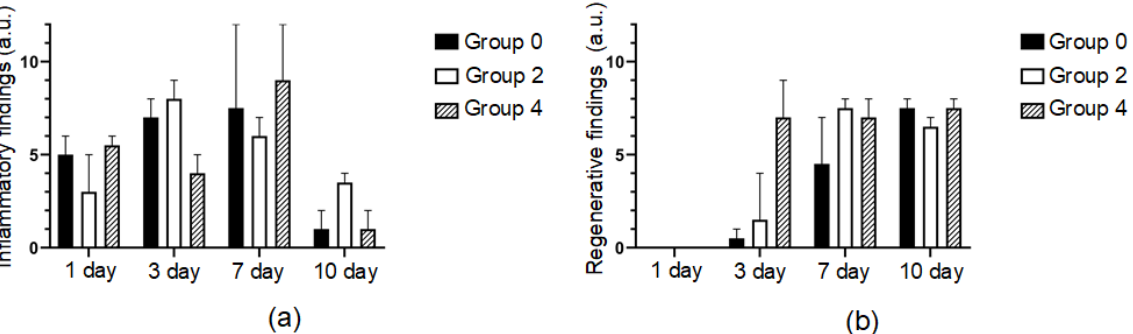
Figure 7. Histograms of inflammatory ( a ) and regenerative ( b ) processes in defect areas treated with traditional sutures (group 0), laser soldering with BSA+ICG (group 2) or BSA+ICG+SWCNT (group 4) on 1, 3, 7, 10 postoperative days. Mean values ± SD.